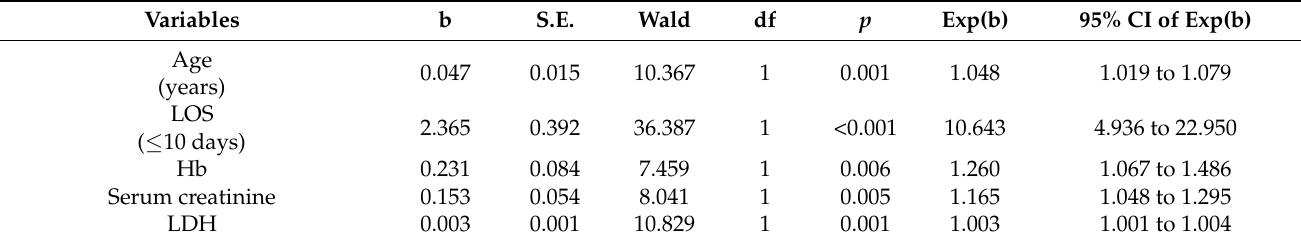
Table 7. The relative instantaneous risks of